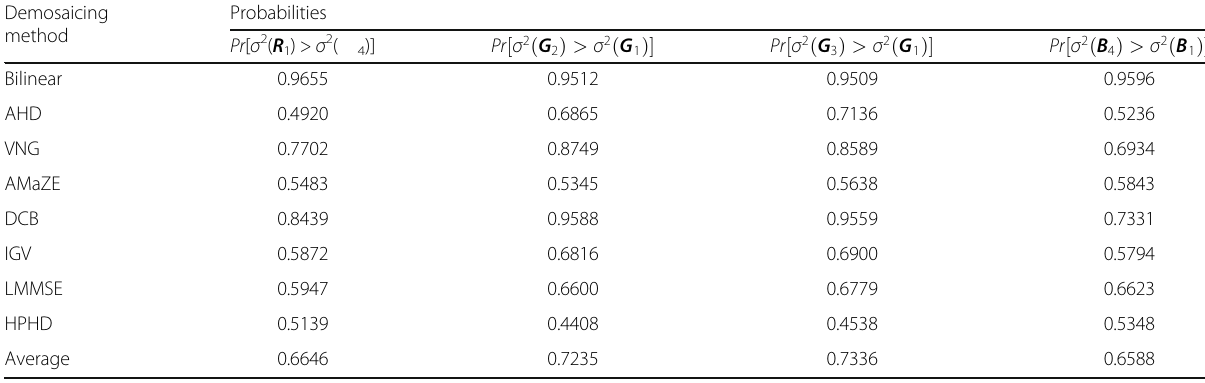
Table 1 Probabilities that the variance of the original block is larger than that of the interpolated block for various demosaicing algorithms (Bayer configuration C 1 is used)